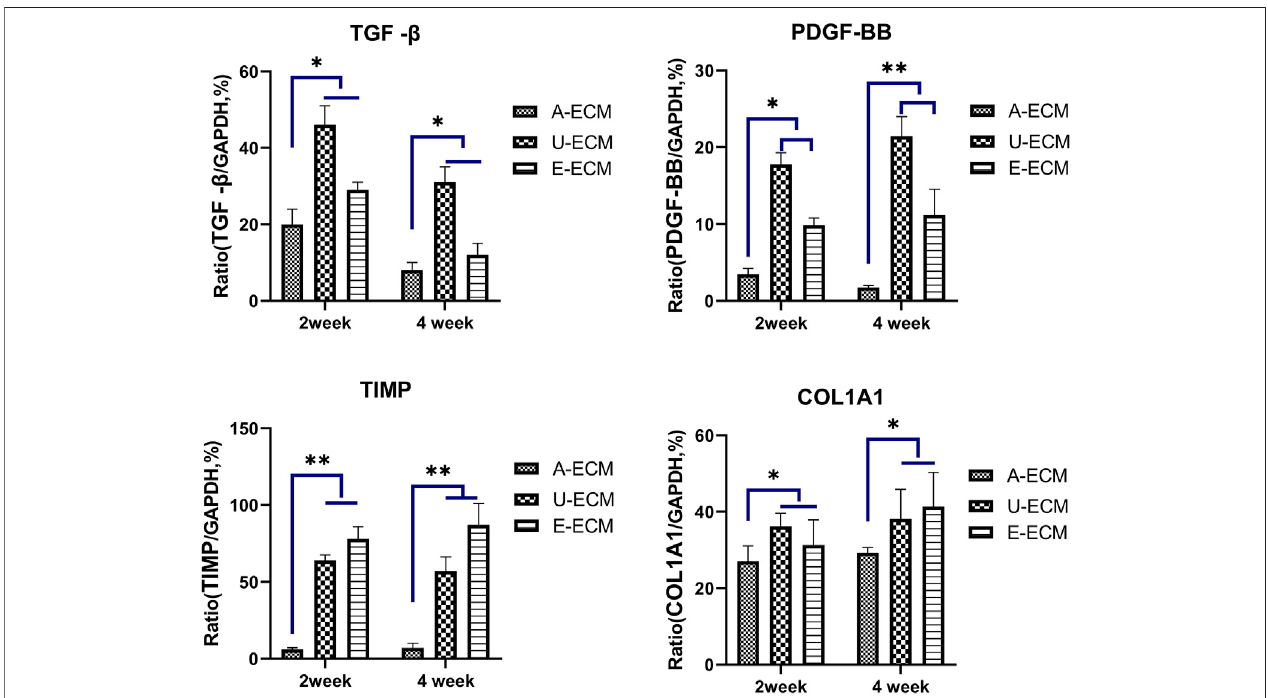
FIGURE5| PostoperativemRNAlevelsof fi brosis-relatedcytokinesineachgroup.Atpostoperativeweeks2and4,themRNAexpressionlevelsof fi brosis-related cytokines (TGF β , TIMP, PDGF-BB, and COL1A1) in the uterine tissues of the experimental groups were assayed by qRT-PCR and compared among the groups. * p < 0.05 and ** p < 0.01, one-way ANOVA with Tukey ’ s post hoc